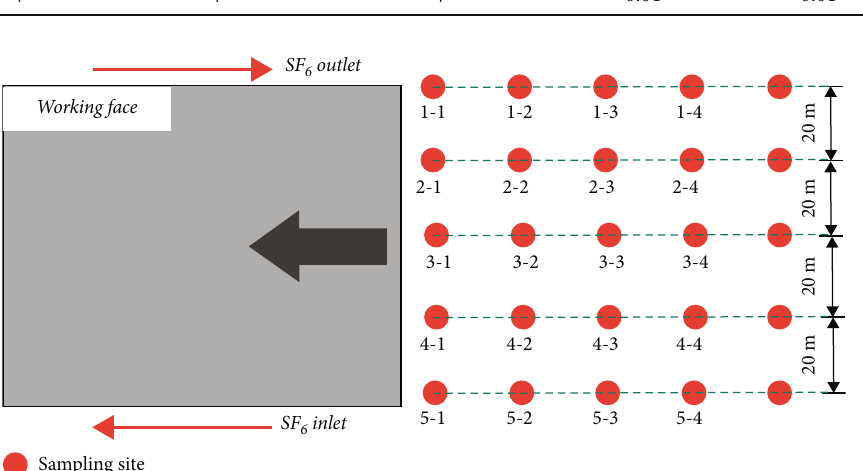
Figure 8: Arrangement of gas sampling points in the mining area of the working